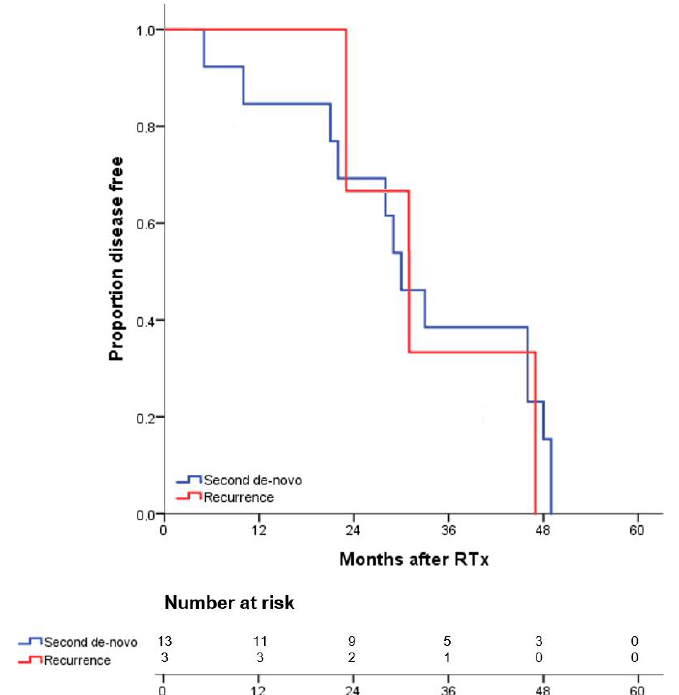
Figure 1. Kaplan-Meier curves for five-year disease-free survival from recurrence and second de- novo malignancy. Kaplan-Meier curves for five-year disease-free survival from recurrence, de-novo or second de-novo